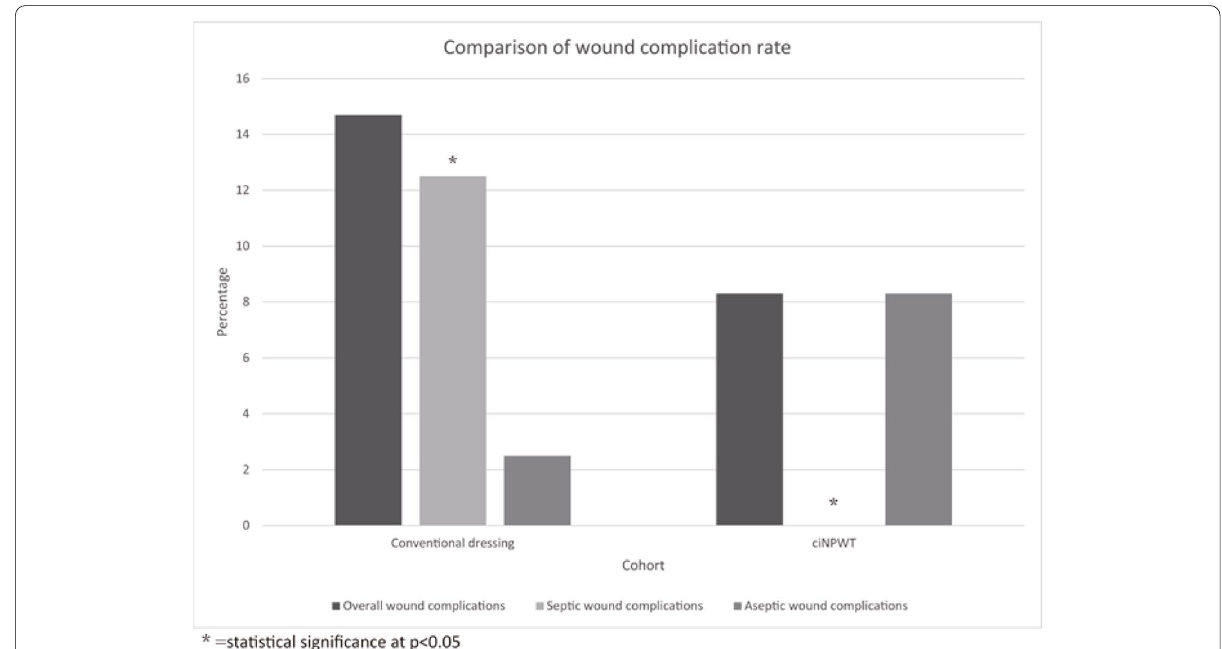
Fig. 2 Comparison of wound complication rate. *